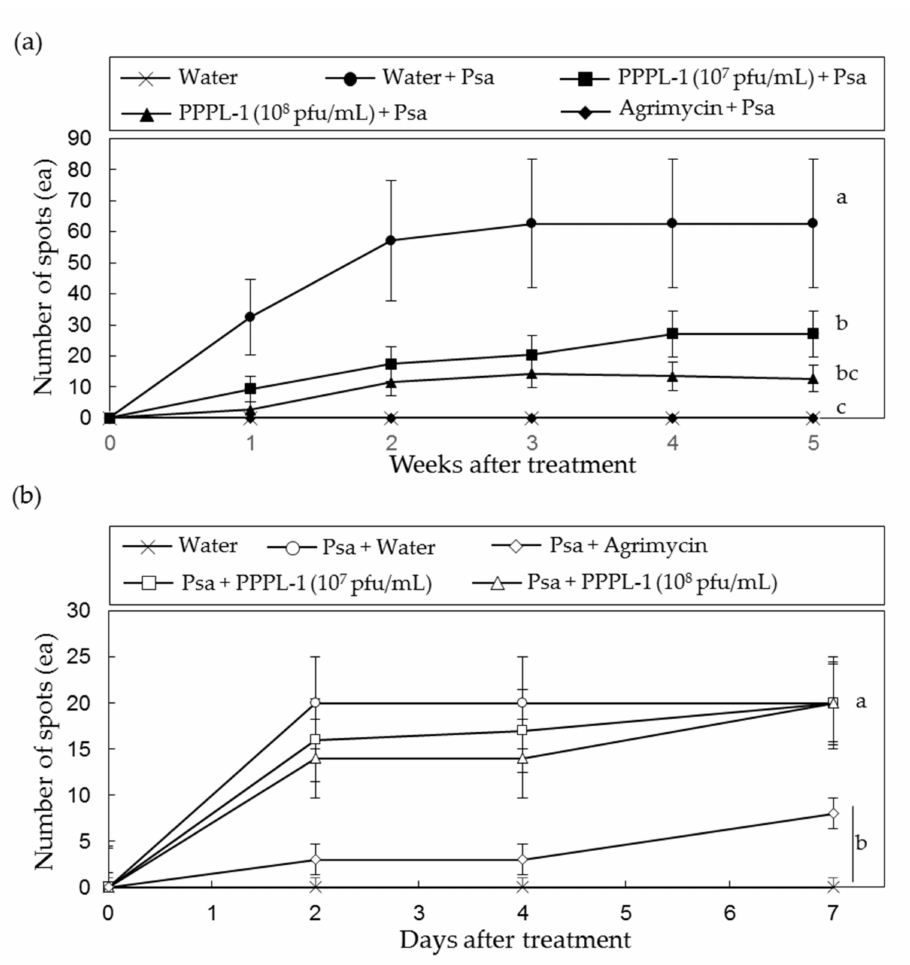
Figure 3. Effects of phage concentration and timing of phage treatment on control efficacy of PPPL-1 phage treatment against bacterial canker caused by Pseudomonas syringae pv. actinidiae (Psa) KBE9 in kiwifruit leaves. ( a ) Leaves were treated with phages at 10 7 and 10 8 pfu/mL by brushing on both sides of leaves, then Psa was applied on the same sides 2 h later. ( b ) Leaves were inoculated with Psa on both sides of leaves by brushing, then phages at 10 7 and 10 8 pfu/mL were applied on the same sides by brushing. The front treatment of each treatment label was first applied, and the back one was treated 2 h later. The error bars indicate the standard error ( n = 20), and the different alphabets in the next of lines indicate the different groups based on significant differences at p < 0.05 by Duncan’s multiple range test at 5 weeks or 7 days after